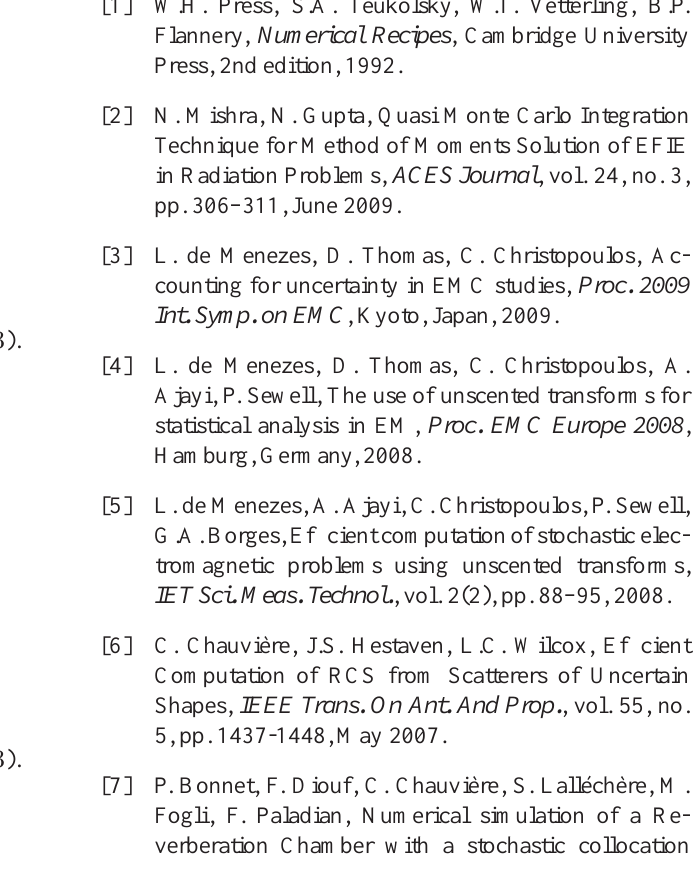
Figure 16: Relative influence criterion ˜ In